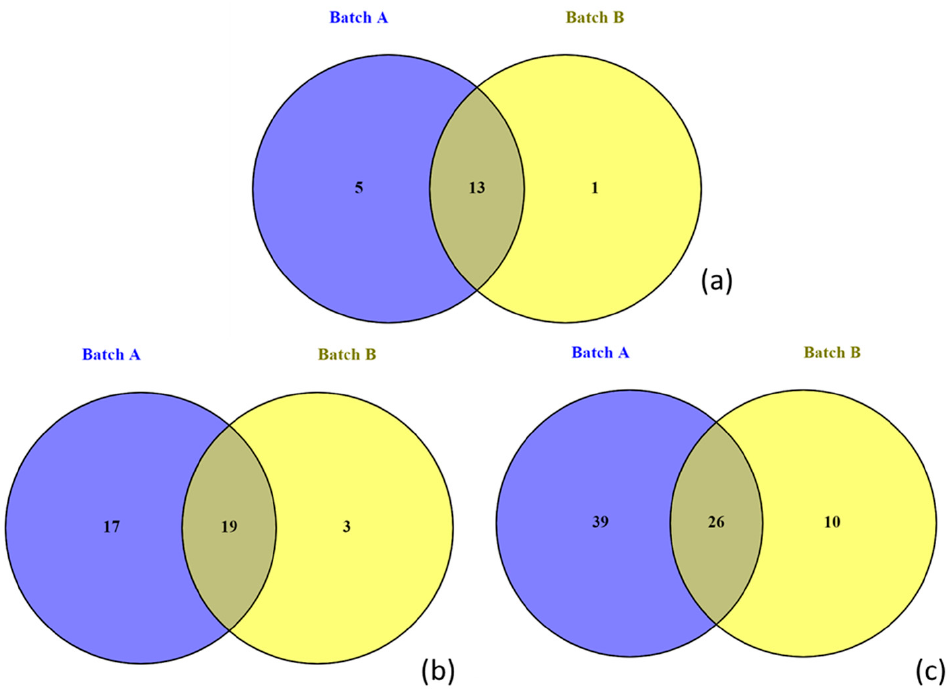
Figure 3. Venn diagrams showing the OTUs shared between batch A and batch B of cheese at the family ( a ) , genus ( b ), and species level ( c ).